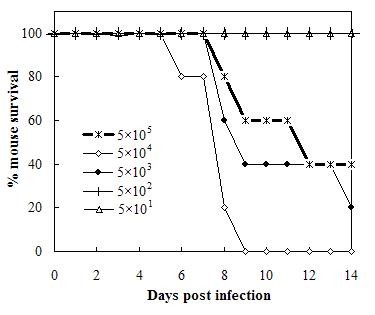
Survival ratios of mice following intranasal infection with different doses of influenza A/PR/8/34 (H1N1) viruses. Groups of five mice were infected intanasally with 5 × 105 (*), 5 × 104 (◇), 5 × 103 (♦), 5 × 102 (┼) or 5 × 101 (△) p.f.u. A/PR/8/34 (H1N1) viruses and were observed consecutively for 14 d.